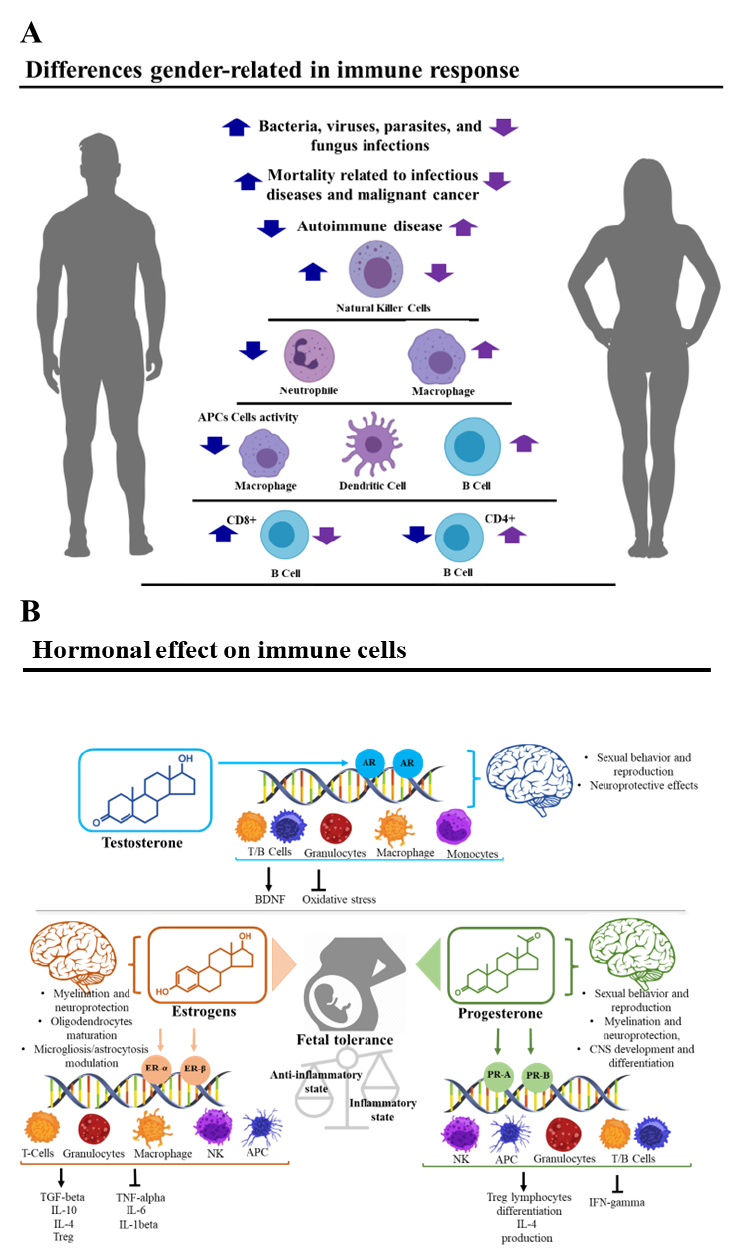
Figure 1. ( A ) Main differences in the immune response between men and women. Blue arrows represent the trend in the men while violet arrows represent the trend in the women. Innate immune cell number and activity differ between males and females. Males present a higher number of natural killer cells compared to females, while phagocytic activity of neutrophils and macrophages is higher in females [4]. Additionally, antigen-presenting cells (APCs) are more efficient in females than males [4]. Sex hormones and an XY karyotype also influence adaptive immunity. Differences between the two sexes are present in B lymphocytes, CD4+, and CD8+ T lymphocytes. For